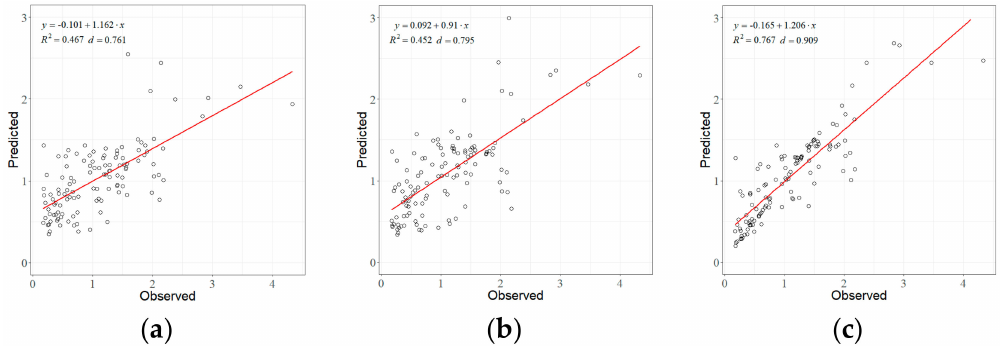
Figure 7. Scatter plots of the predicted LAI against the observed LAI in Kangbao using three models: ( a ) traditional kNN; ( b ) RF; and ( c ) modified